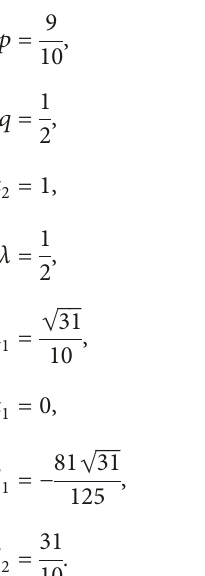
Figure 1: The interaction solution (46) with parameters being fixed by (49): (a) two-dimensional plot with t with x (cid:29)